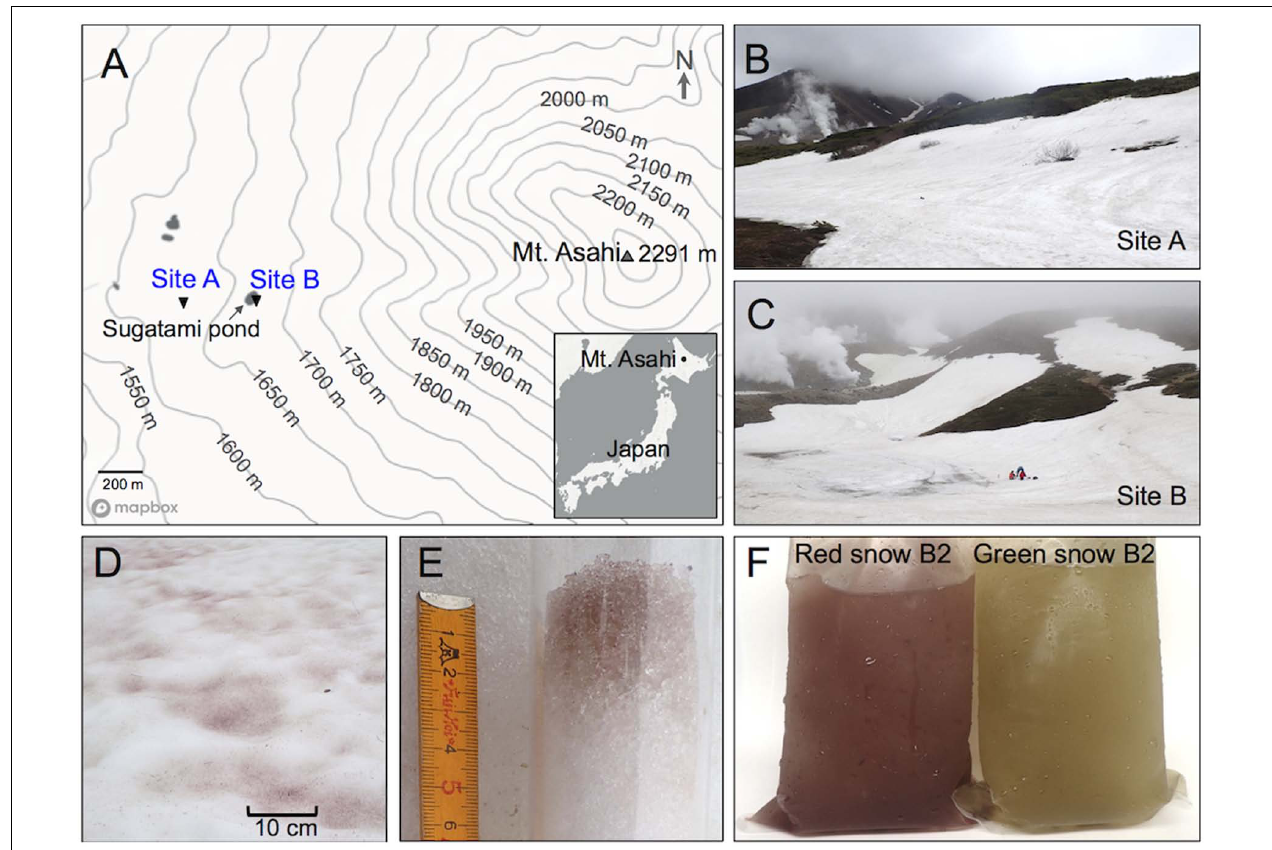
FIGURE 1 | (A) Sampling sites of Mount Asahidake. (B) Sampling site A snowfield. (C) Sampling site B snowfield. (D) Red snow surface of sampling site A snowfield. (E) Removing a core from the snow (sample red snow B2) shows coloration from the algae in the top 3 cm of the snow. (F) Melted green and red snow samples from B2 sampling. (Map generated by © Mapbox, © OpenStreetMap, modified and annotated). TABLE 1 | Cell density, pH, conductivity, and concentrations of aqueous dissolved carbon (DOC) and major ions in the filtered snow samples. Red snow A1 Red snow B2 Green snow B2 White snow B2 Cell density ∼ 1 × 10 5 cells ml −